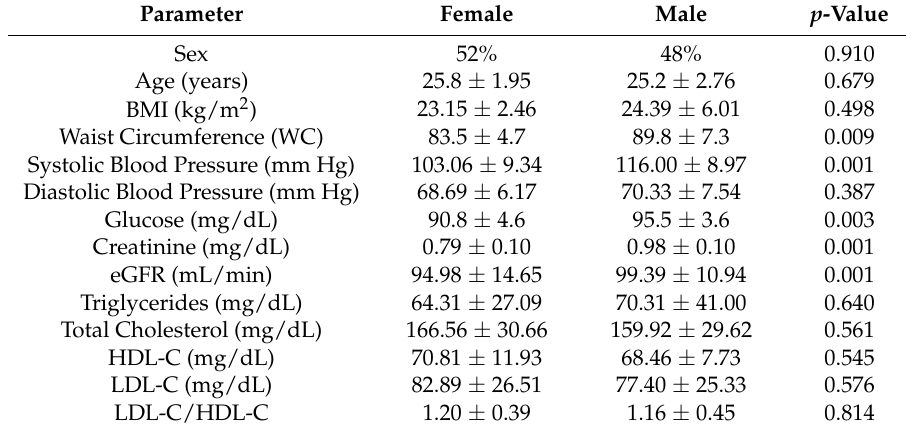
Table 2. Baseline characteristic of young, healthy women and men ( n = 30) participating in 13-week crossover intervention with intake of eggs versus choline supplement for 4 weeks each.